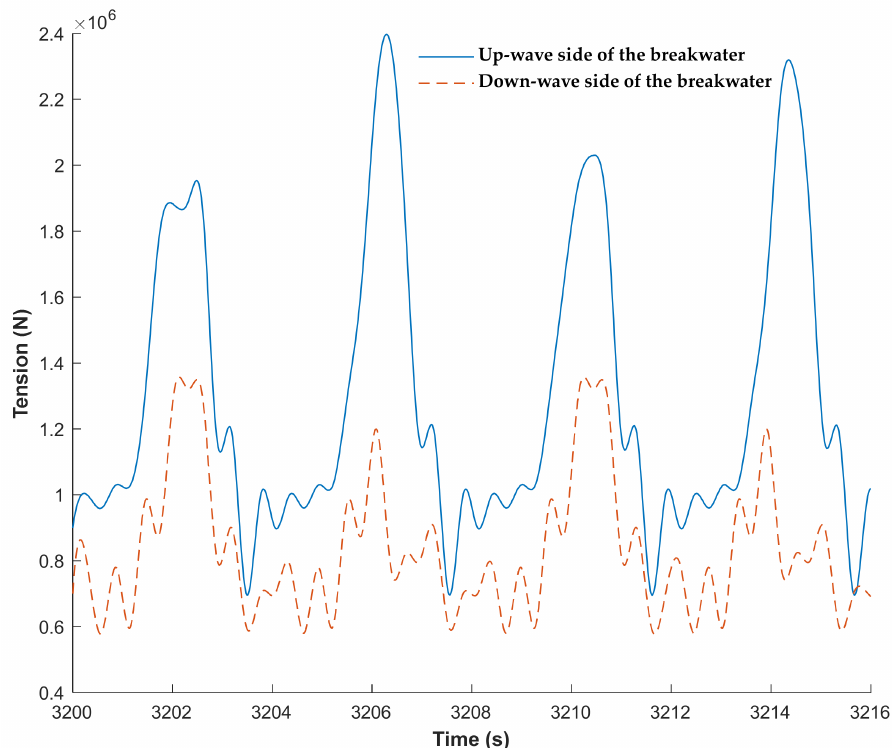
Figure 7. Stress histories of the mooring line at a fairlead point in a regular wave.